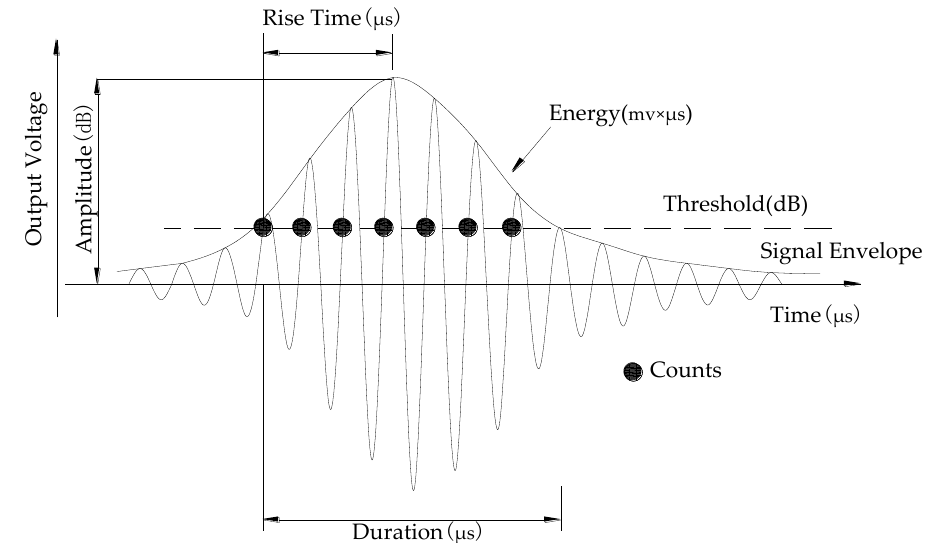
Figure 4. S chematic diagram of acoustic emission (AE) parameters. Figure 4. Schematic diagram of acoustic emission (AE)